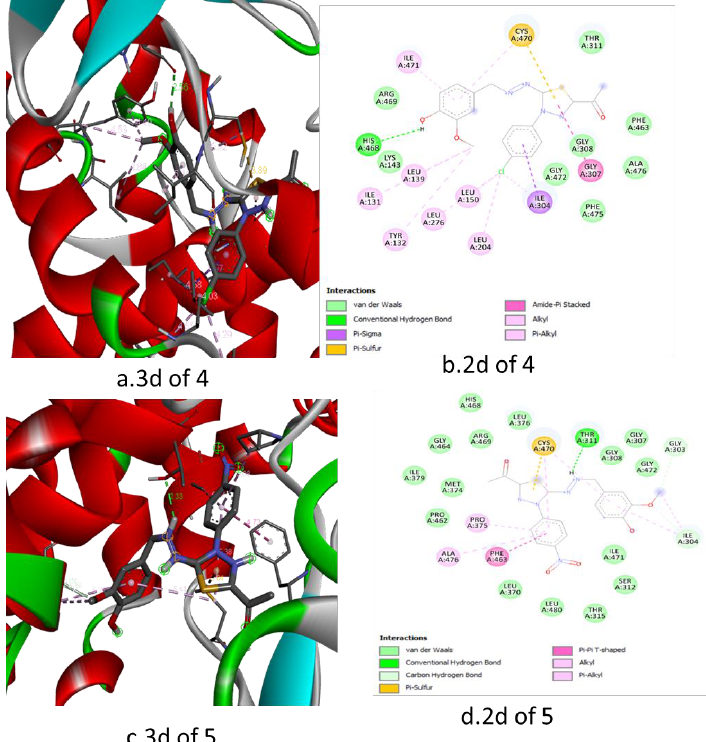
Figure 12. Interaction of the docked compounds 4 and 5 with fungal sterol 14 α -demethylase (CYP51).